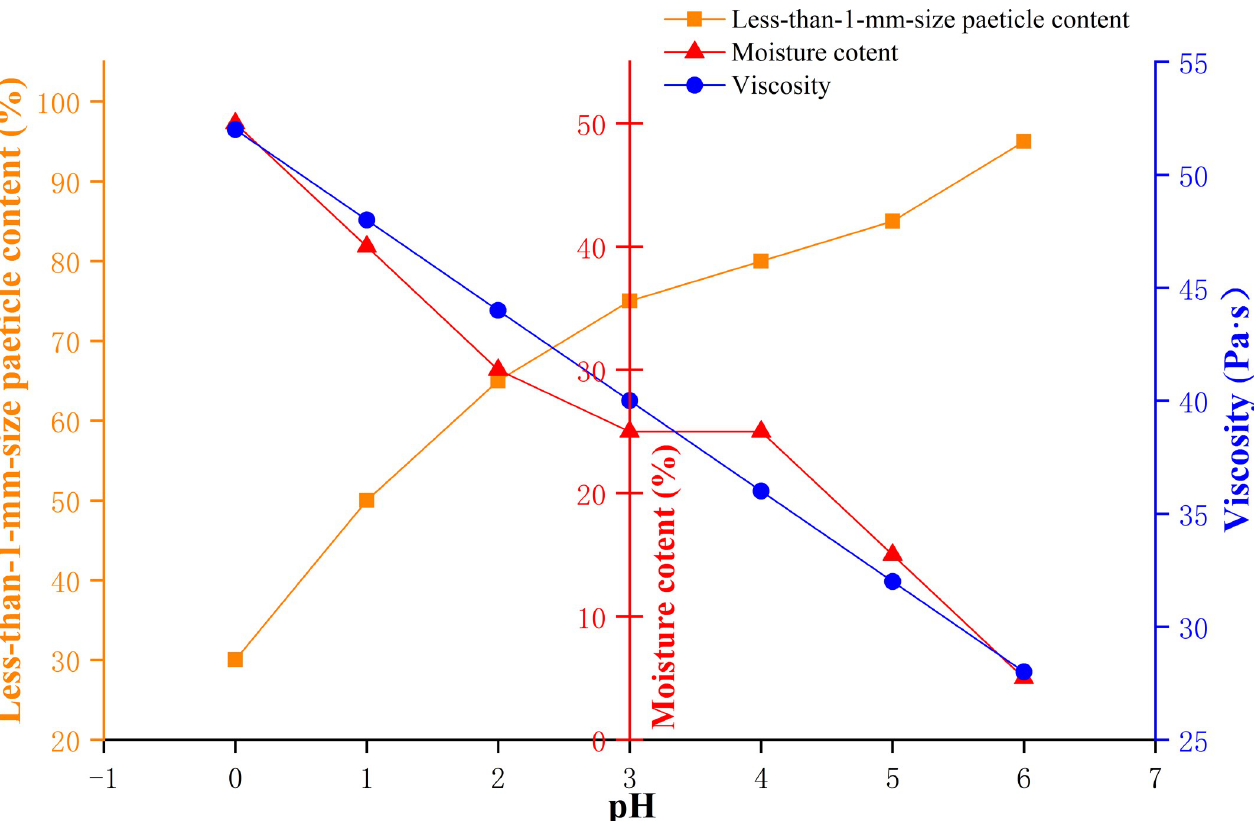
Fig 18. Effects of mud viscosity, water content and particle content smaller than 1 mm on the acid resistance of a mud film.